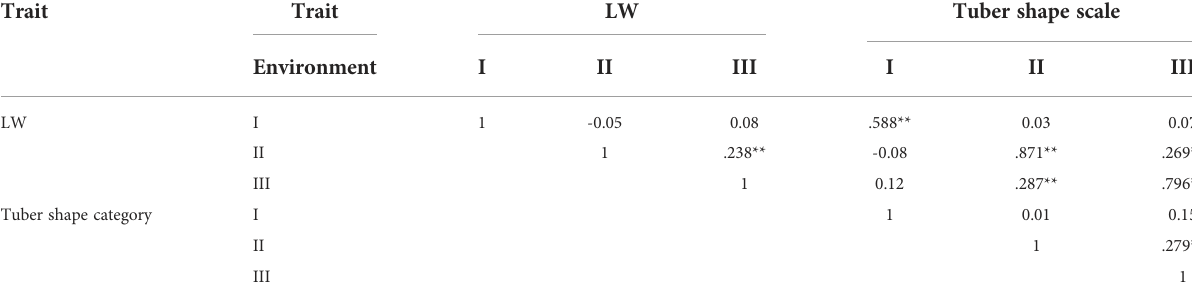
TABLE 2 Correlation coef fi cients of the tuber shape traits in three environments.